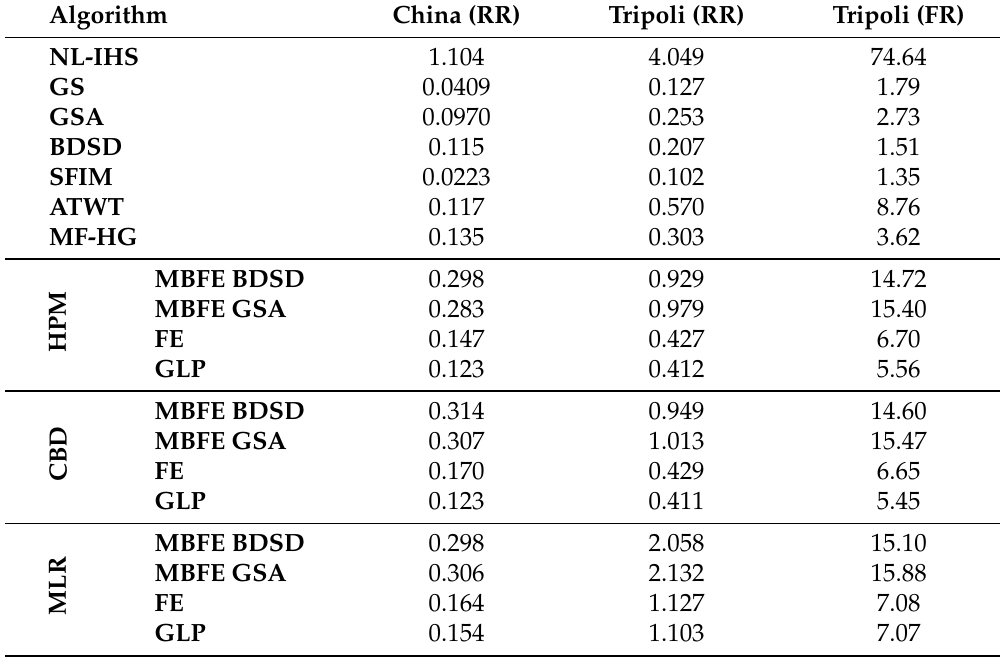
Table 3. Computational times (in seconds) required for the datasets